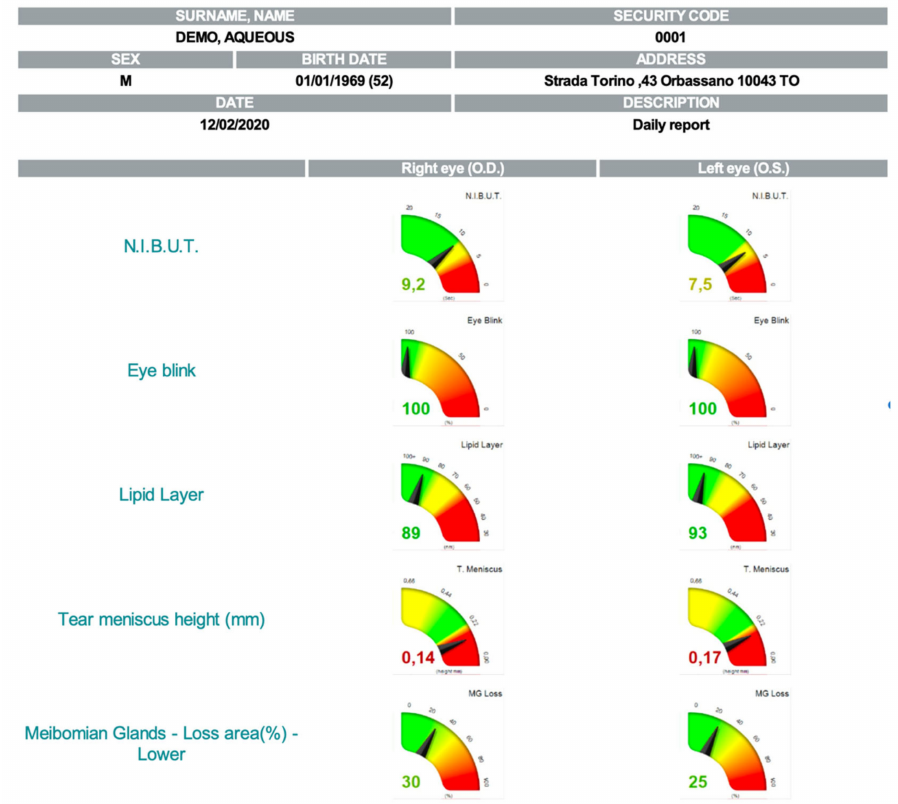
Figure 2. Dry Eye report obtained with the use of IDRA (Sbm Sistemi, Inc., Torino, Italy), including non- invasive break-up time, eye blink, lipid layer, tear meniscus height, and loss area of meibomian glands.